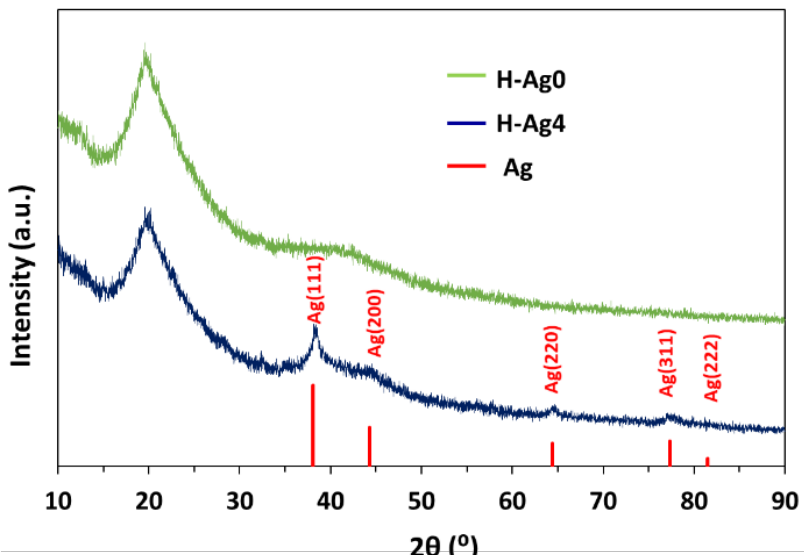
Figure 7. XRD patterns of the PVA/CS/OA hydrogels with (H-Ag4) and without AgNPs (H-Ag0), together with the reference patterns of silver (space group 225:Fm-3m, Card No. 9008459). The release of silver from the composite hydrogels was studied in simulated physio- logical conditions (PB pH = 7.4, 37 ◦ C) and the results are shown in Figure 8. As expected, the hydrogels with a large amount of embedded CS-AgNPs release high amounts of silver in the buffered solution. The diffusion of silver continues almost linearly for the first 7 h, after which it reaches a plateau. After 11 days, the hydrogels do not release more than 0.4% from the incorporated silver, showing that AgNPs are well trapped in the polymeric